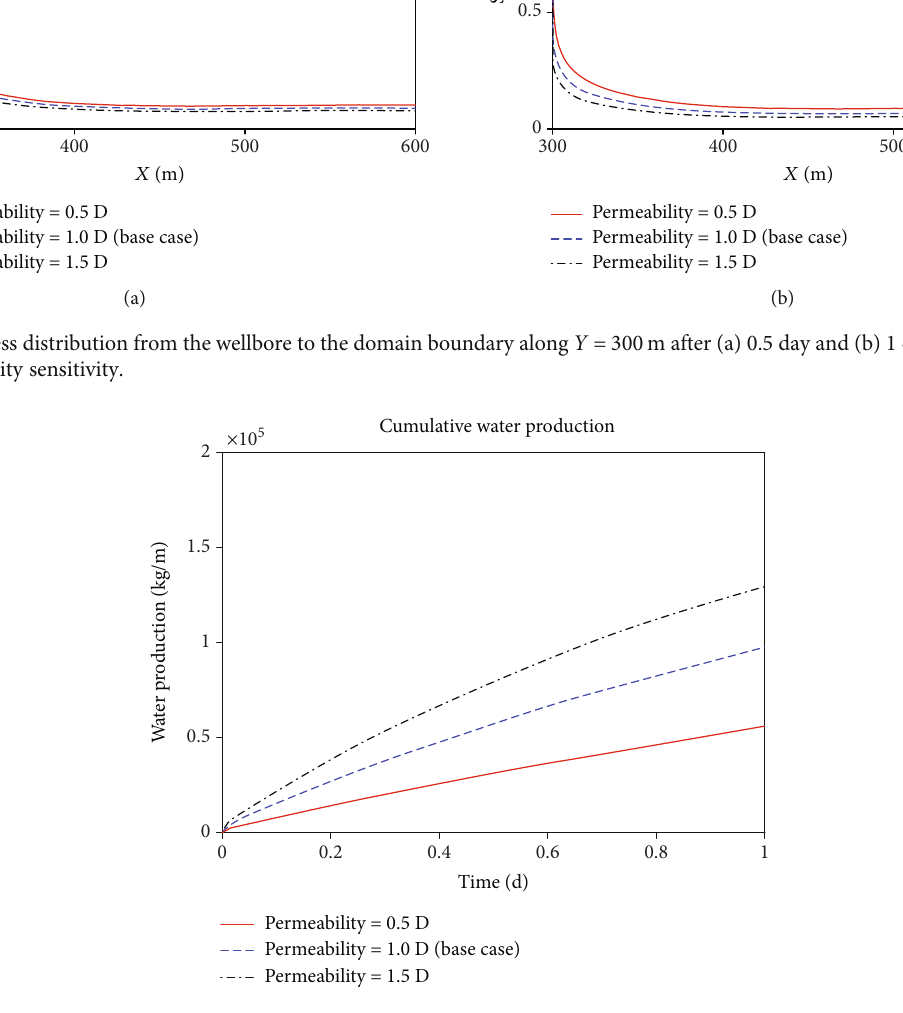
Figure 11: Cumulative water production at the wellbore during one day of shallow water fl ow for permeability